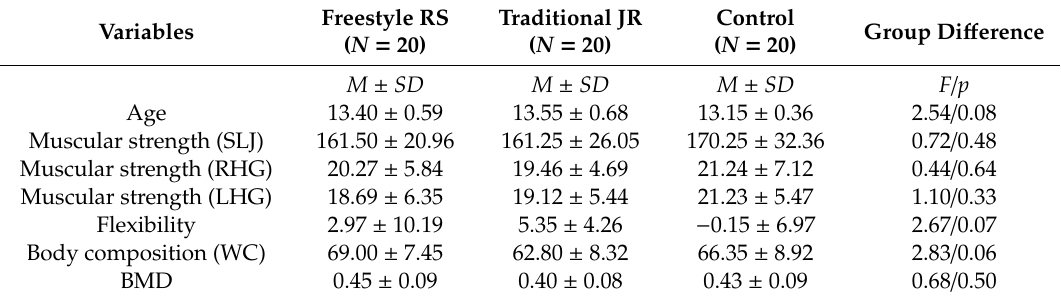
Freestyle RS Traditional JR Control Group Di ff erence ( N = 20) ( N = 20) ( N = 20) M ± SD